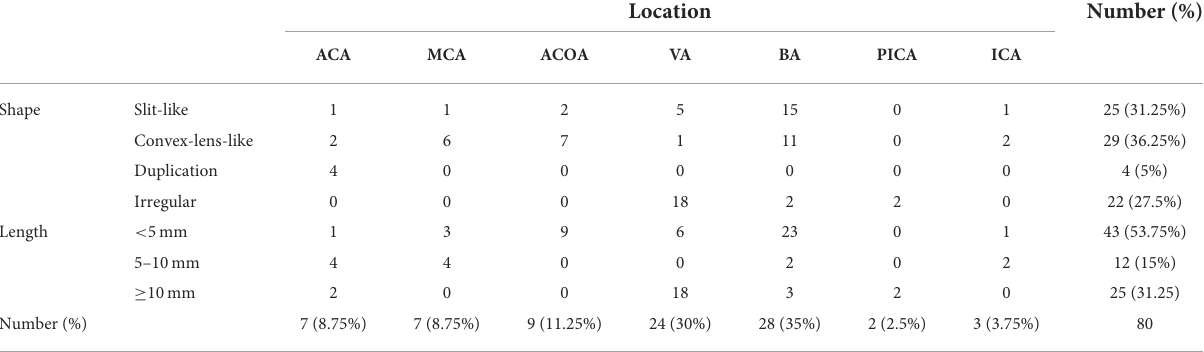
TABLE 5 Shape and differential location of cerebral artery fenestrations among the